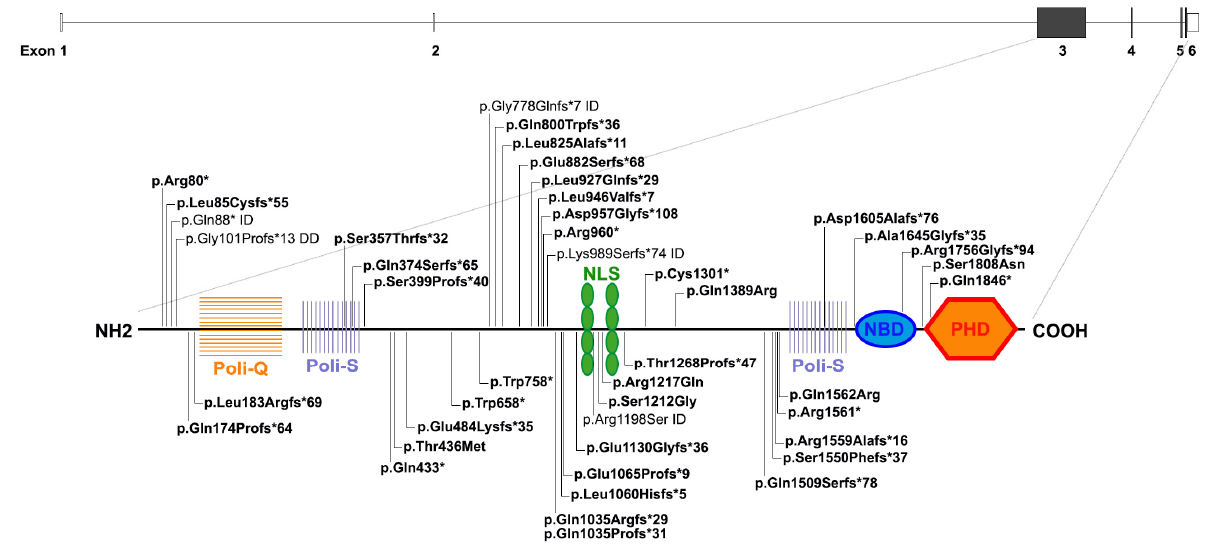
Figure 2. RAI1 gene and protein structures. At the top, RAI1 gene structure based on RefSeq NM_030665, including noncoding exons (white) and coding regions (dark grey). At the bottom, RAI1 protein structure with seven key functional domains, starting with N-terminal a polyglutamine rich tract (Poly-Q, orange), a polyserine rich domain (Poly-S, light purple), a bipartite Nuclear Localization Signal (NLS, green), a second Poly-S tract (light purple), a nucleosome-binding domain (NBD, blue), and a C-terminal “plant homeo-domain” (PHD, red). The pathogenic SMS-associated reported truncating and missense mutations are indicated in bold in the protein structure, the remaining variations reported are not associated with SMS, but with indicated conditions, according to HGMD Professional (version 3 September 2021) and ClinVar database. ID; intellectual disability, DD; developmental